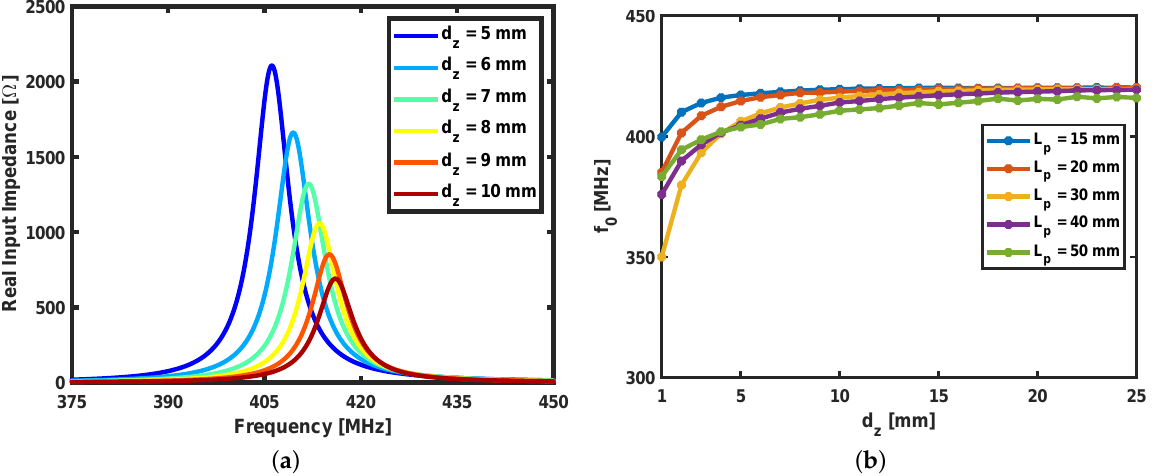
Figure 8. ( a ) Real input impedance vs. frequency as d z varies from 5 to 10 mm for the sensor with L p = L tag = 30 mm, w = s = 2 mm, N = 2 turns. ( b ) Resonant frequency vs. d z for varying L p at L tag = 30 mm, w = s = 2 mm, N = 2